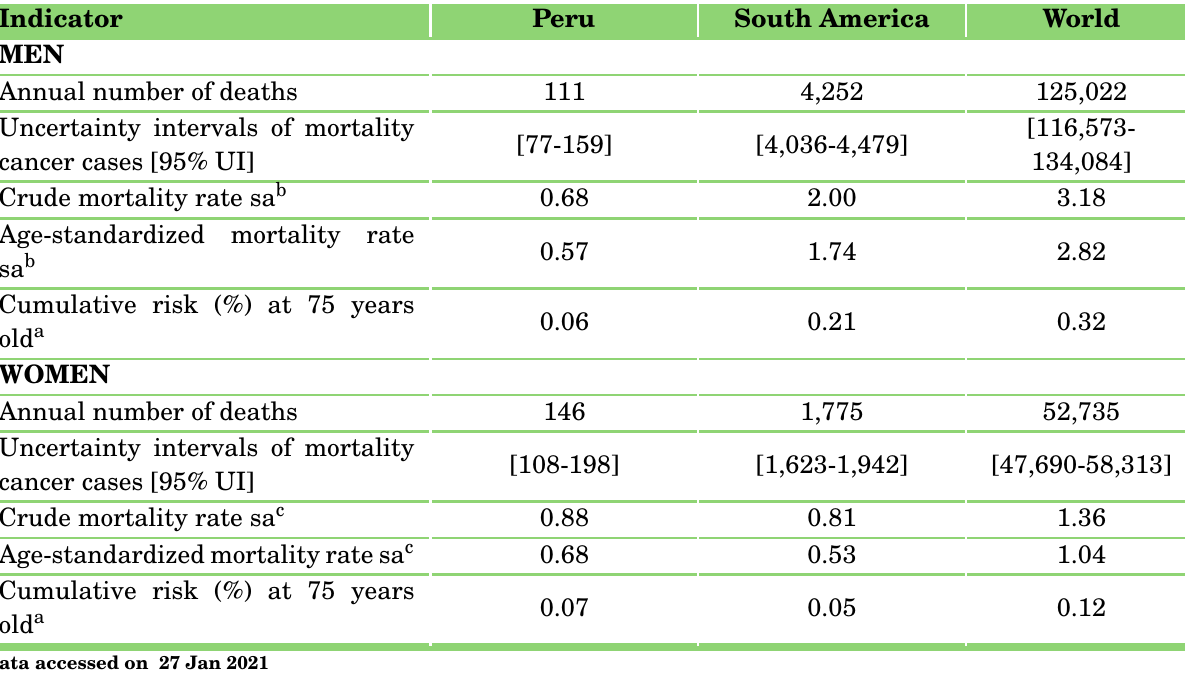
Table 18: Oral cavity cancer mortality in Peru (estimates for 2020) Indicator